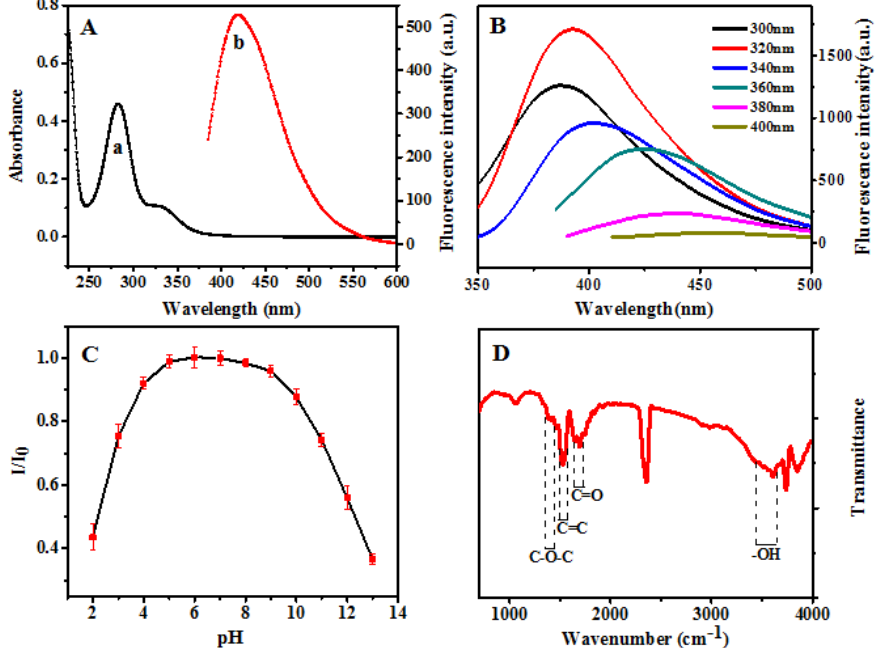
Figure 2. ( a ) UV-vis absorption spectra (black line) and ( b ) fluorescence spectra (red line, at 360 nm excitation) of the carbon dots (CDs) ( A ); ( B ) excitation-dependent property and ( C ) pH-dependence of the CDs for different pH conditions (I 0 corresponds to the initial fluorescence intensity at pH = 7.0); ( D ) FTIR spectra of the CDs.